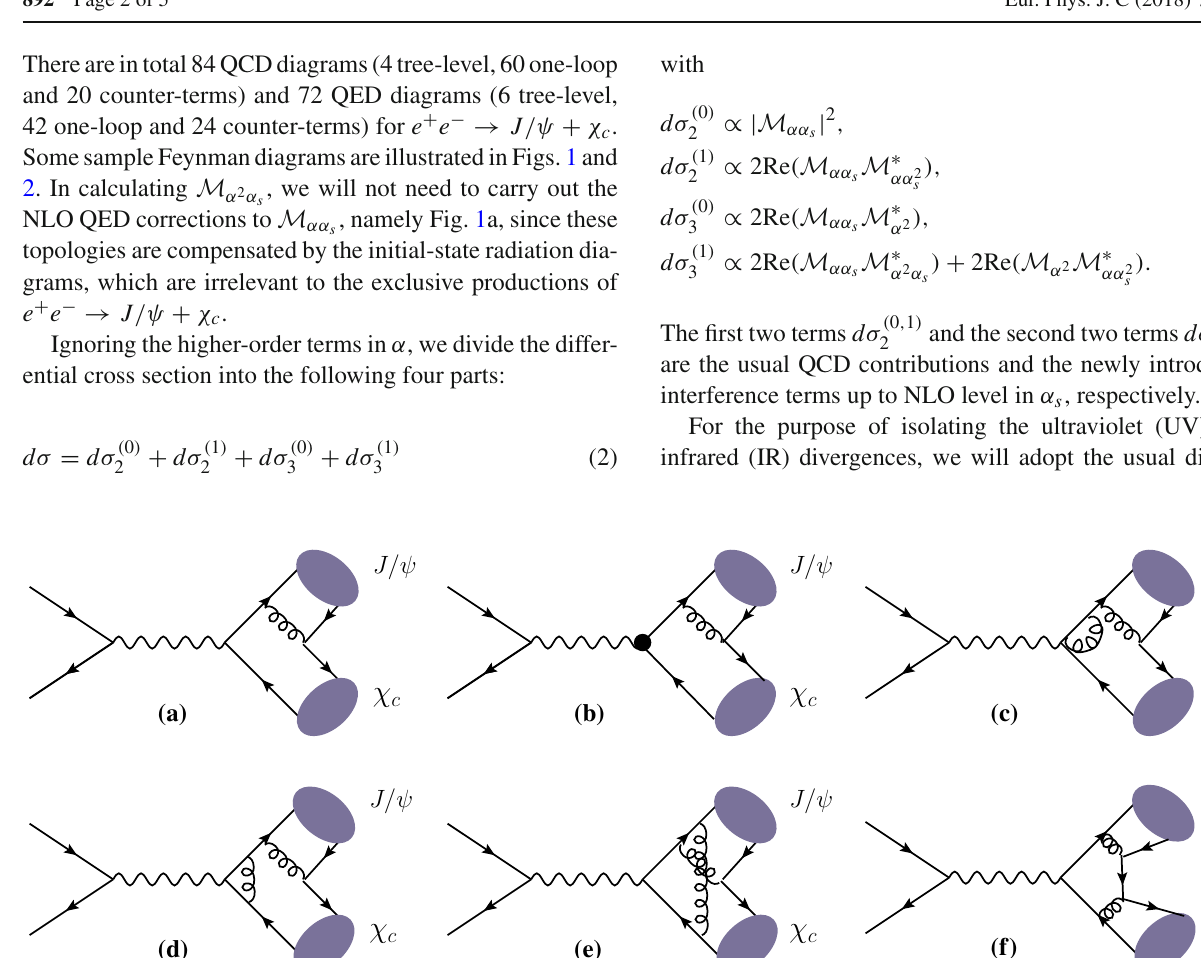
) is the QCD tree-level diagram. b – f ( M αα 2 s